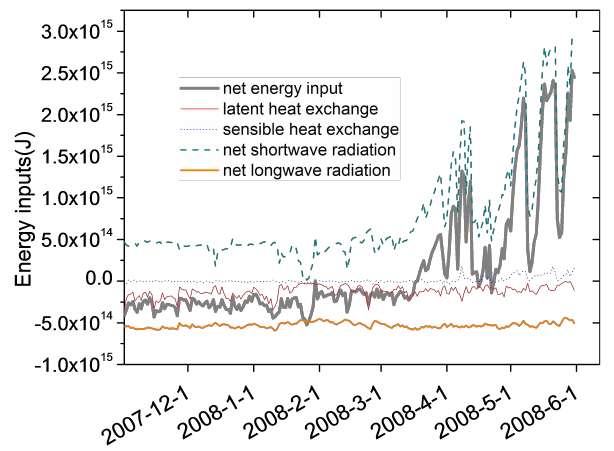
Fig. 3. Different daily energy inputs to the snowpack of the total watershed in the 2008 snow season.